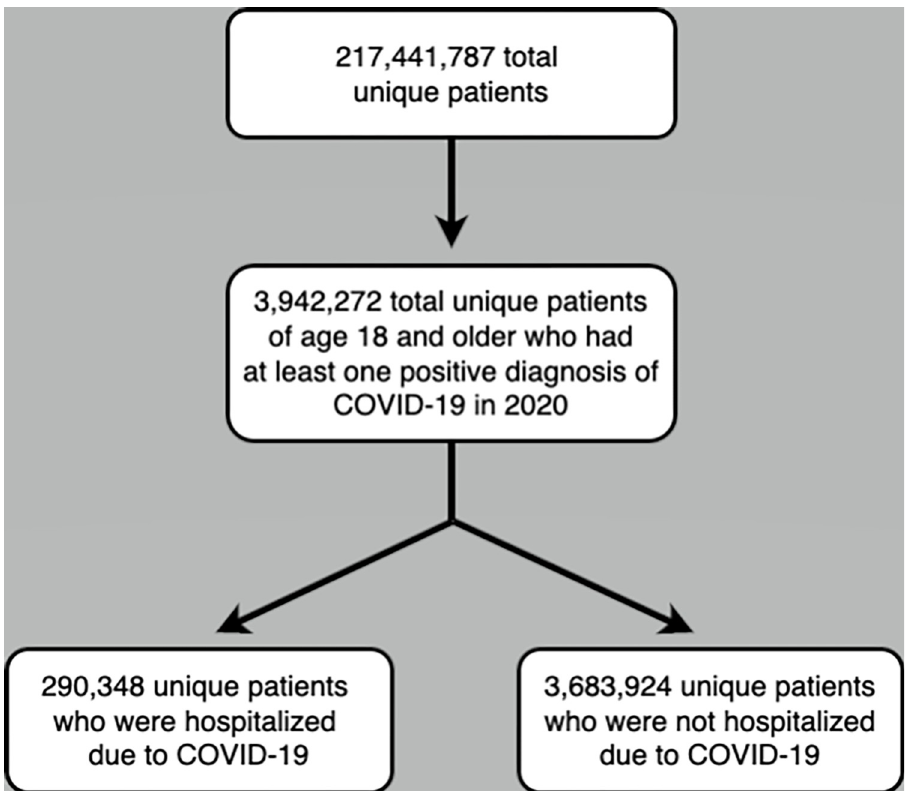
Fig 1. Flow chart showing the total number of patients in the database and exclusions that result in the final number of patients included in the study.